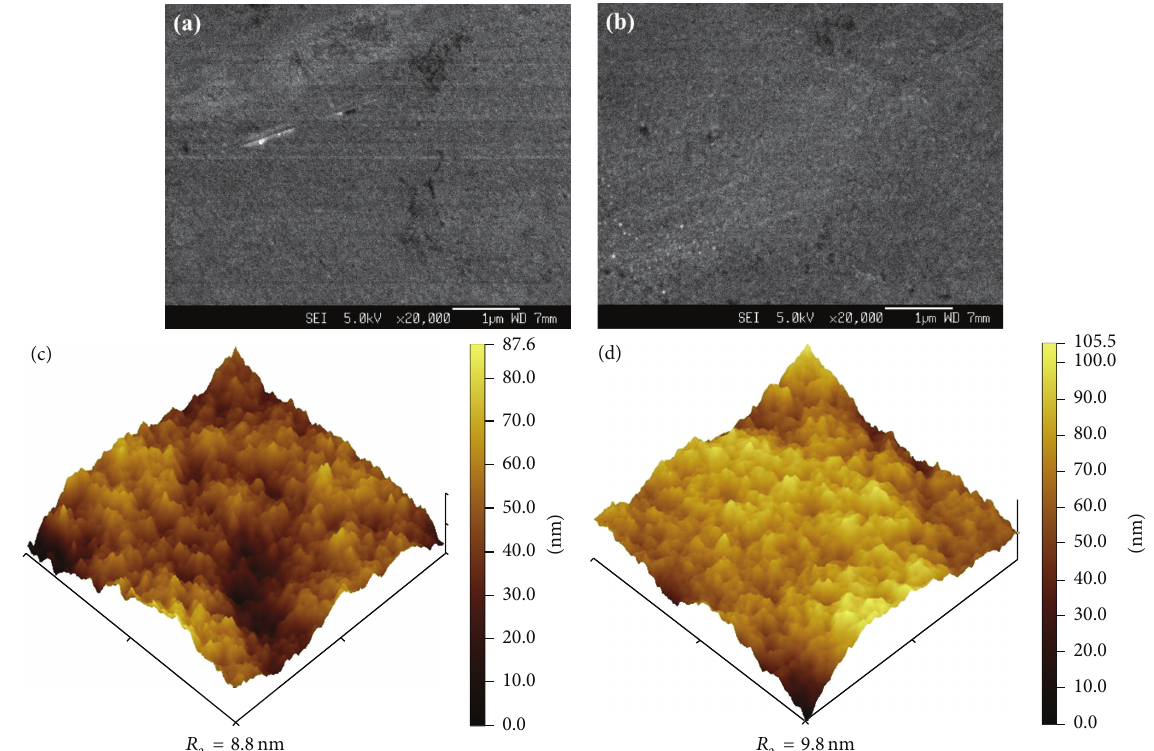
Figure 7: Scanning electron micrographs of Ag films electrodeposited by (a) high cyanide and (b) low cyanide silver solutions; the 3D AFM ) of Ag films electrodeposited by (c) high cyanide and (d) low cyanide silver solutions. images and surface roughness ( 𝑅 a